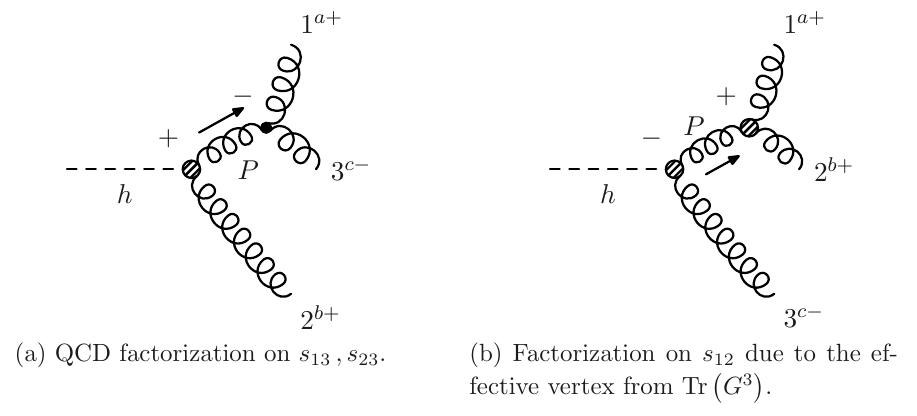
Figure 2. Possible factorizations of the + +